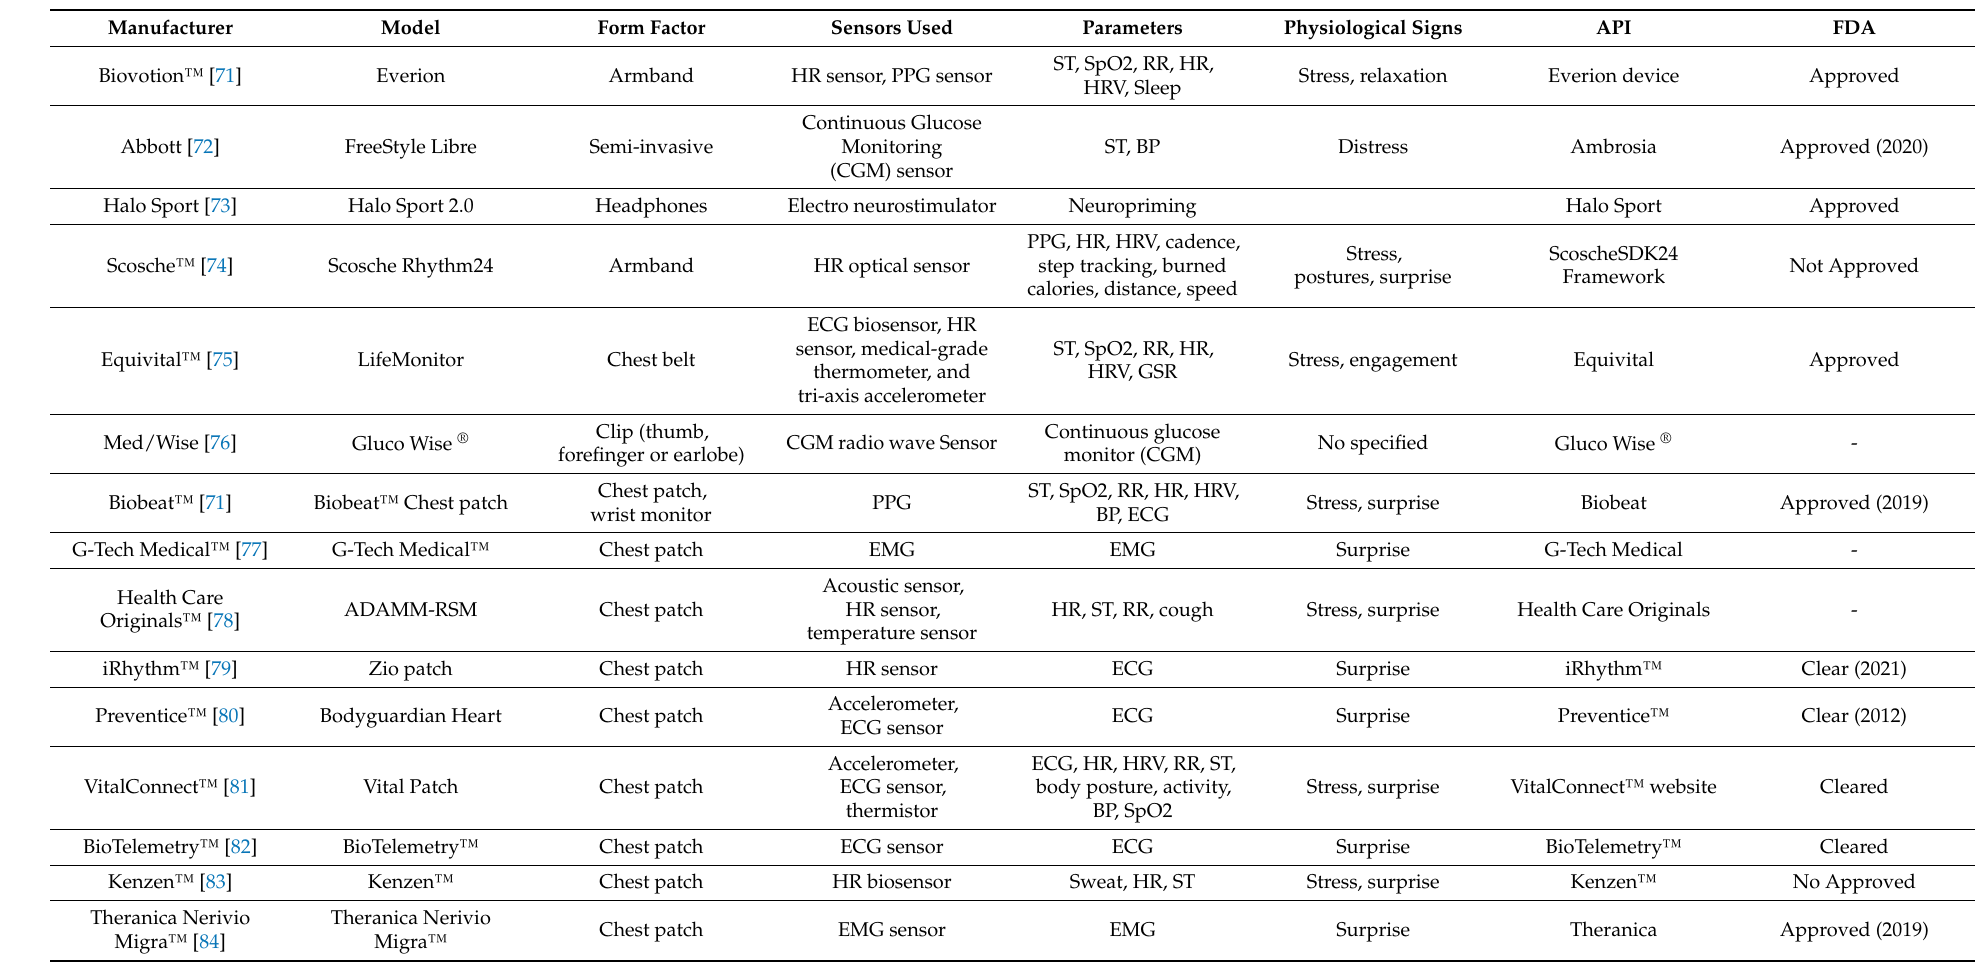
Table 2. Commercial Wearable Devices for Engagement